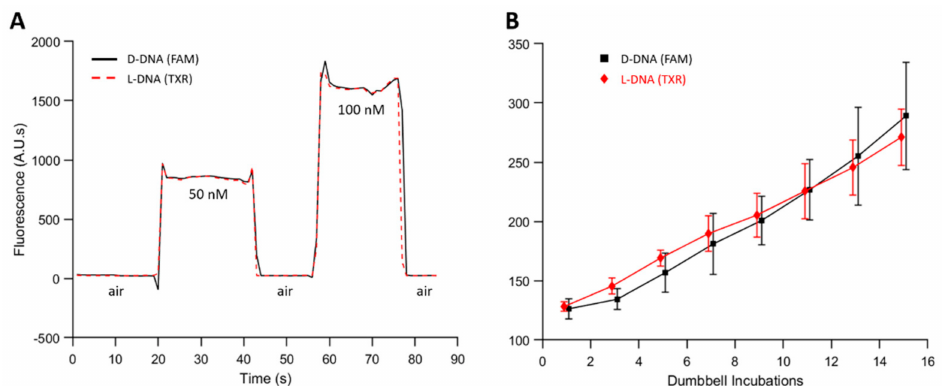
Figure 5. Matching D-DNA and L-DNA fluorescent signals in the autoPiLOT. ( A ) Reaction chambers containing D-DNA and L-DNA dumbbells at 50 and 100 nM were passed through the optical path of the autoPiLOT fluorometer. ( B ) No-target control reactions performed on the autoPiLOT measuring both D-DNA (black) and L-DNA (red) fluorescence. The mean of three trials ± one standard deviation is shown.